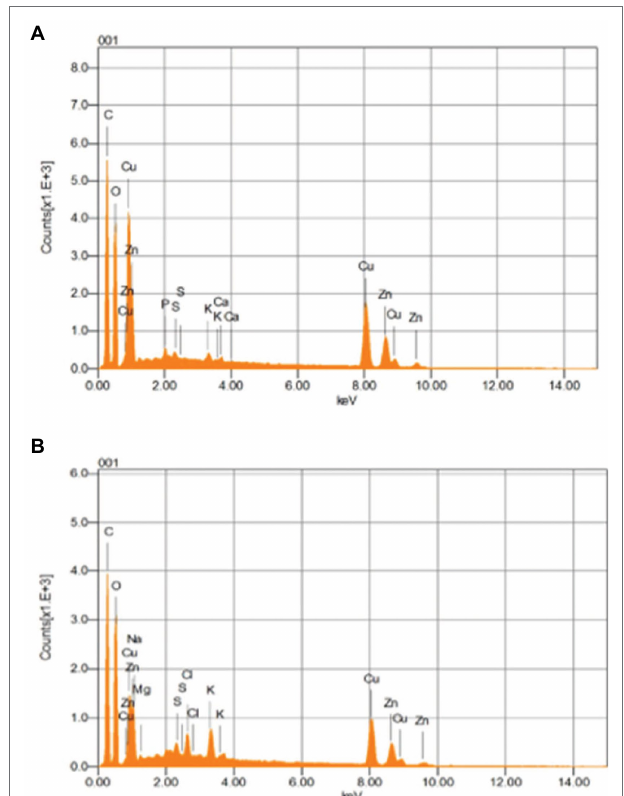
FIGURE 9 | EDX images of B. altitudinis MT422188 in (A) with (B) without